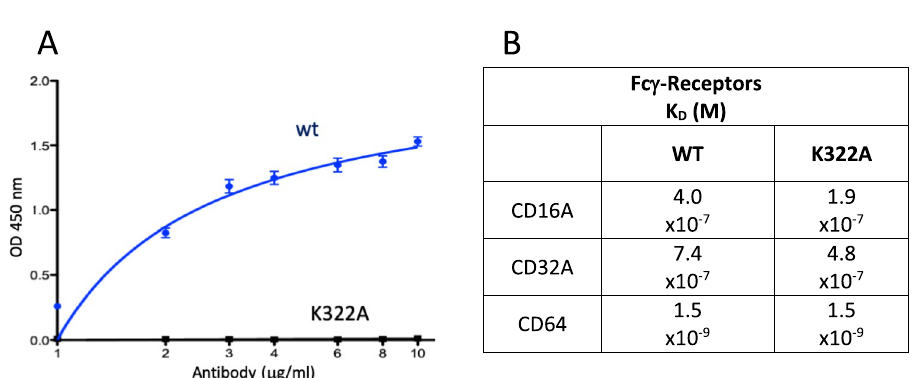
Figure 5. Binding of four A β monomers to PBD-C06. The interactions of four monomeric A β peptides pE3-A β (3–18) ( A ), A β (3–18) ( B ), A β (1–18) ( C ) and A β (4–18) ( D ) to PBD-C06 were analyzed with a Biacore 3000 SPR instrument. 2150 RU of PBD-C06 were captured on a Biacore CM5 Chip via an immobilized anti- human antibody. The interactions of the A β peptides with the captured PBD-C06 antibody were analyzed with a flow rate of 30 µ l/min and injecting 240 µ l of different concentrations of the peptides (pE3-A β (3–18): 0.2 (light magenta) – 1000 nM (light magenta – upper curve), A β (3–18): 10 (light cyan) – 10000 nM (light magenta), A β (1–18): 200 (light magenta) – 10000 nM (magenta) and A β (4–18): 200 (light magenta) – 10000 nM (magenta)). The sensorgrams were recorded for 2500 sec and evaluated using the 1:1 Langmuir binding model.